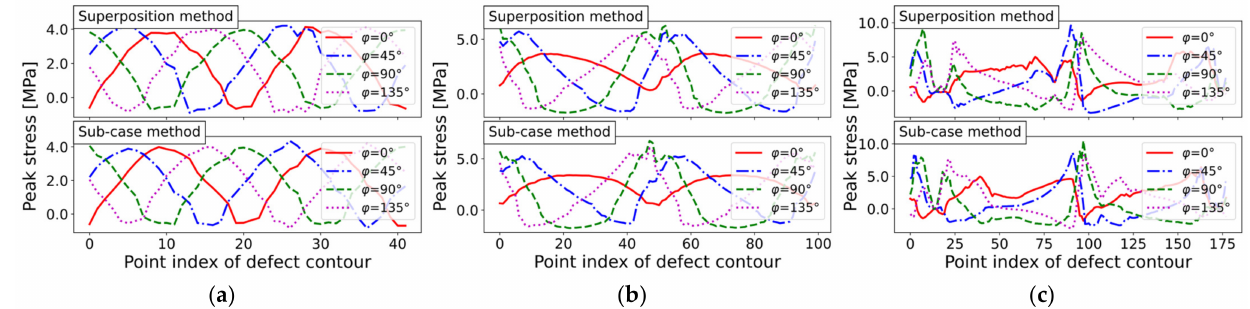
Figure 16. N-SIF peak stress course for three defect geometries, assuming a sharp notch and incremen- tal load step of ∆ ϕ = 10 ◦ : ( a ) Circular hole-in-plate (mesh ‘circle_lin_R1mm_v1’); ( b ) Elliptical hole- in-plate (mesh ‘ellipsis_lin_rot0deg_v1’); and ( c ) Elongated defect (mesh ‘defect_elongated_lin_v1’). The assessed N-SIF values for sharp notches corresponded to the curvature course.